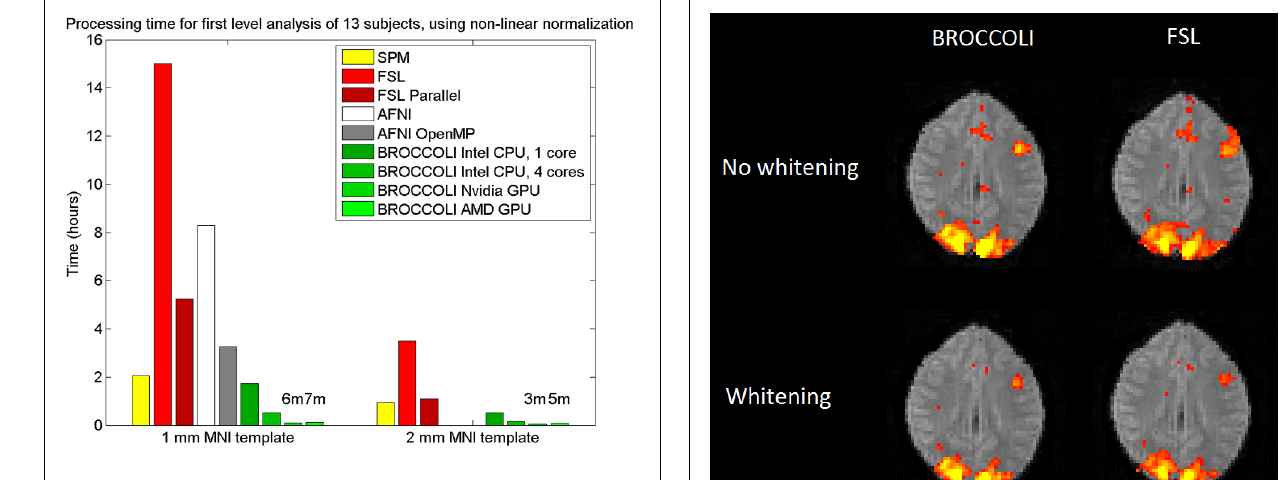
FIGURE 9 | Processing times for first level analysis of 13 fMRI datasets (of size 64 × 64 × 33 × 160). The analysis includes non-linear normalization to a brain template, slice timing correction, motion correction, smoothing, and statistical analysis. A Matlab script, available on the SPM homepage, was used for SPM. For FSL, the analysis was setup and started through the graphical user interface. For AFNI, the analysis was performed with afni _ proc . py , through the graphical user interface uber _ subject . py . It should be noted that SPM, FSL and BROCCOLI use linear and non-linear registration, while AFNI uses linear registration only (currently, it is not possible to select non-linear registration in uber_subject.py). To compensate for this, the non-linear registration for AFNI was done separately. Note that it is not possible to select a 2mm 3 brain template in uber_subject.py, these processing times are therefore not defined. Also note that the processing times for BROCCOLI do not include any first level permutation test.